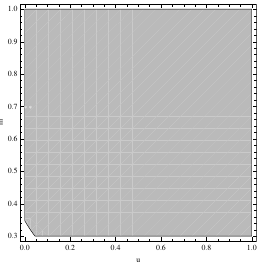
Figure 6. Regions for single curvature extremum for a J-shaped transition